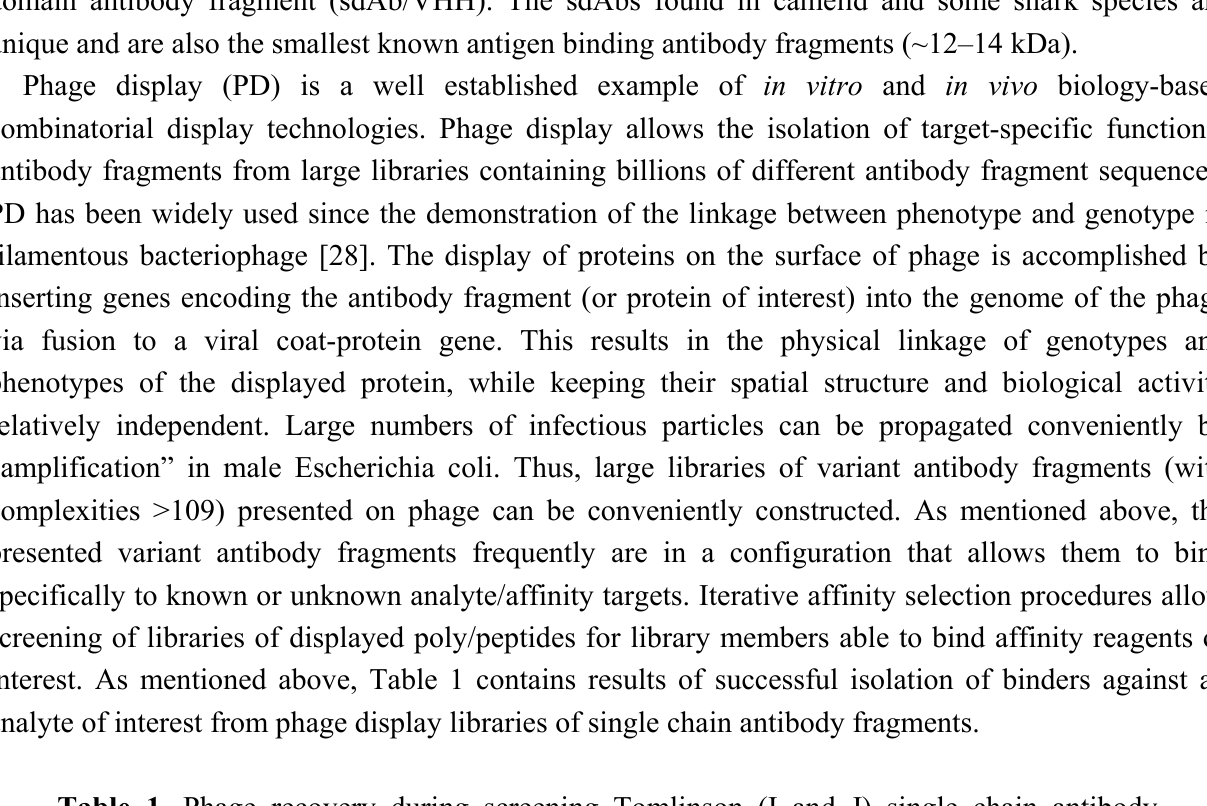
Table 1. Phage recovery during screening Tomlinson (I and J) single chain antibody fragments (scFv) phage display